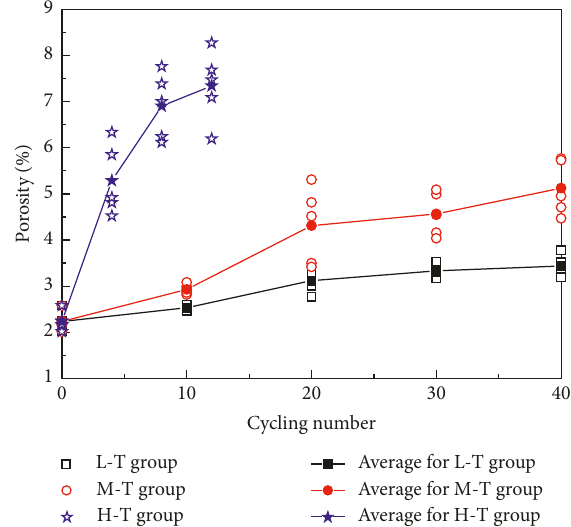
Figure 7: Variation of porosity of sandstone versus H-C